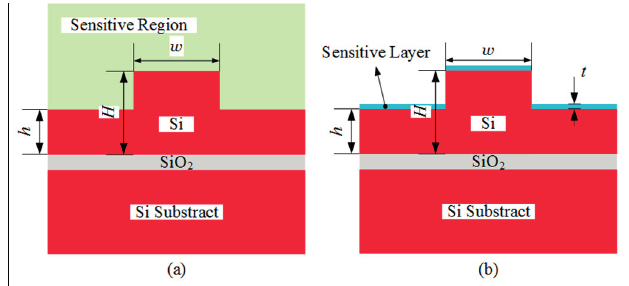
Figure 2. The schematic diagram of sensitive region and sensitive layer at silicon-on-insulator (SOI) rib waveguide with large cross section. ( a ) Homogeneous sensing, the light olive region is the sensitive region; ( b ) Surface sensing, the blue region represents the sensitive layer, and its thickness is denoted by t